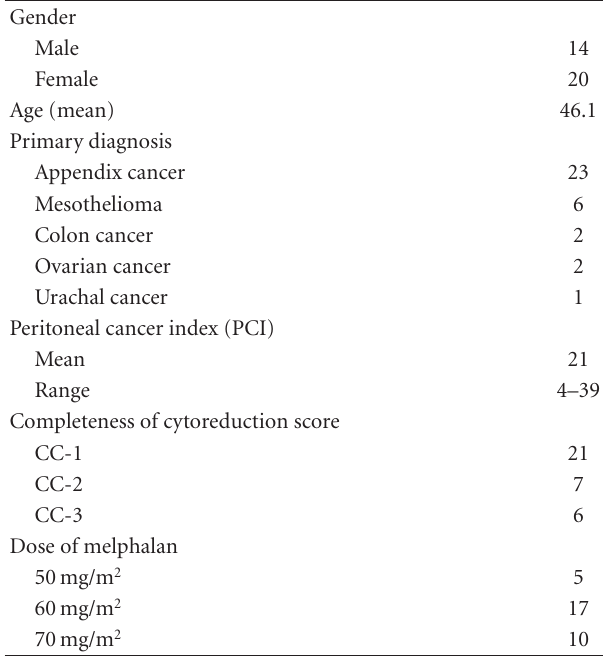
Table 1: Demographic and perioperative data on 34 patients treated with cytoreductive surgery and heated intraperitoneal chemotherapy with